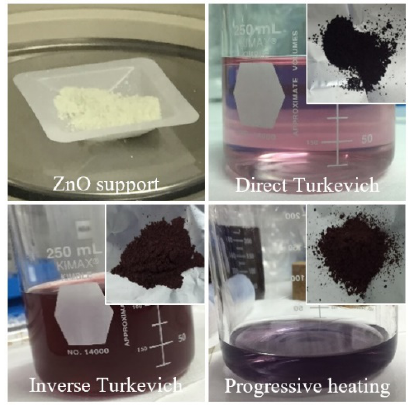
Figure 1. Photographs of the ZnO powder used as photocatalytic support and the supernatant obtained after gold loading using each impregnation method. Insets : Obtained Au-NPs/ZnO powders. The x-ray diffraction (XRD) patterns of the support and Au-NPs/ZnO samples are shown in Figure 2. In the case of the pristine support, all the diffraction peaks correspond to wurtzite zinc oxide ( w -ZnO; JCPSD # 36-1451); no additional reflection associated with a minority phase was detected. Using the Scherrer equation [31], the average crystallite size of the w -ZnO phase was determined to be ~17 nm. The x-ray reflections associated with w -ZnO appear also in the patterns of the three gold- loaded samples. However, neither peak broadening nor diffraction angle shift was observed. This indicates that the methods used for metal loading do not induce any significant change in the ( c -Au; JCPDS # 04-0784) appear in the diffractograms of the three Au-NPs/ZnO samples. The average